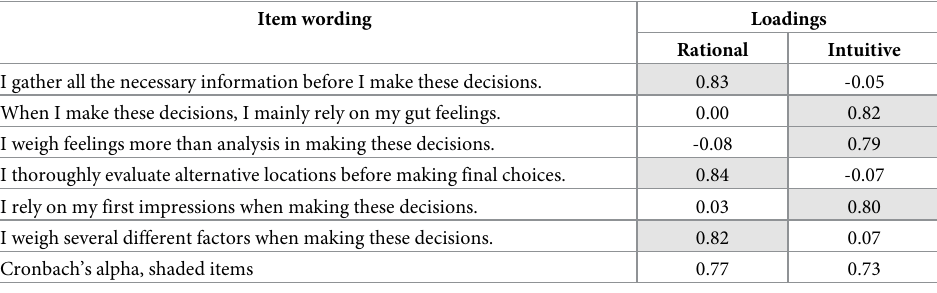
Table 4. Decision style scale factor